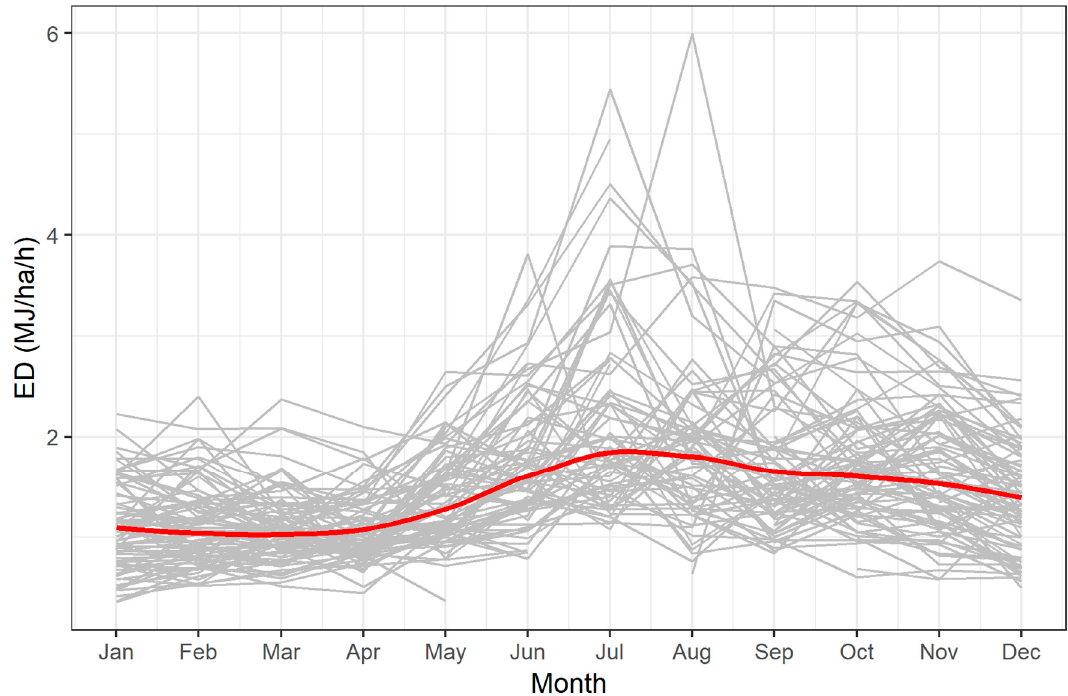
Figure 4. The grey lines represent the average monthly ED of all the stations used in clustering analysis. Some of these lines have no values for some months due to missing values. The red line symbolizes the mean annual ED values coming from all the stations, after smoothing by means of Local Polynomial Regression Fitting [59], as a non-parametric method to present smooth curves between the plotted variables.